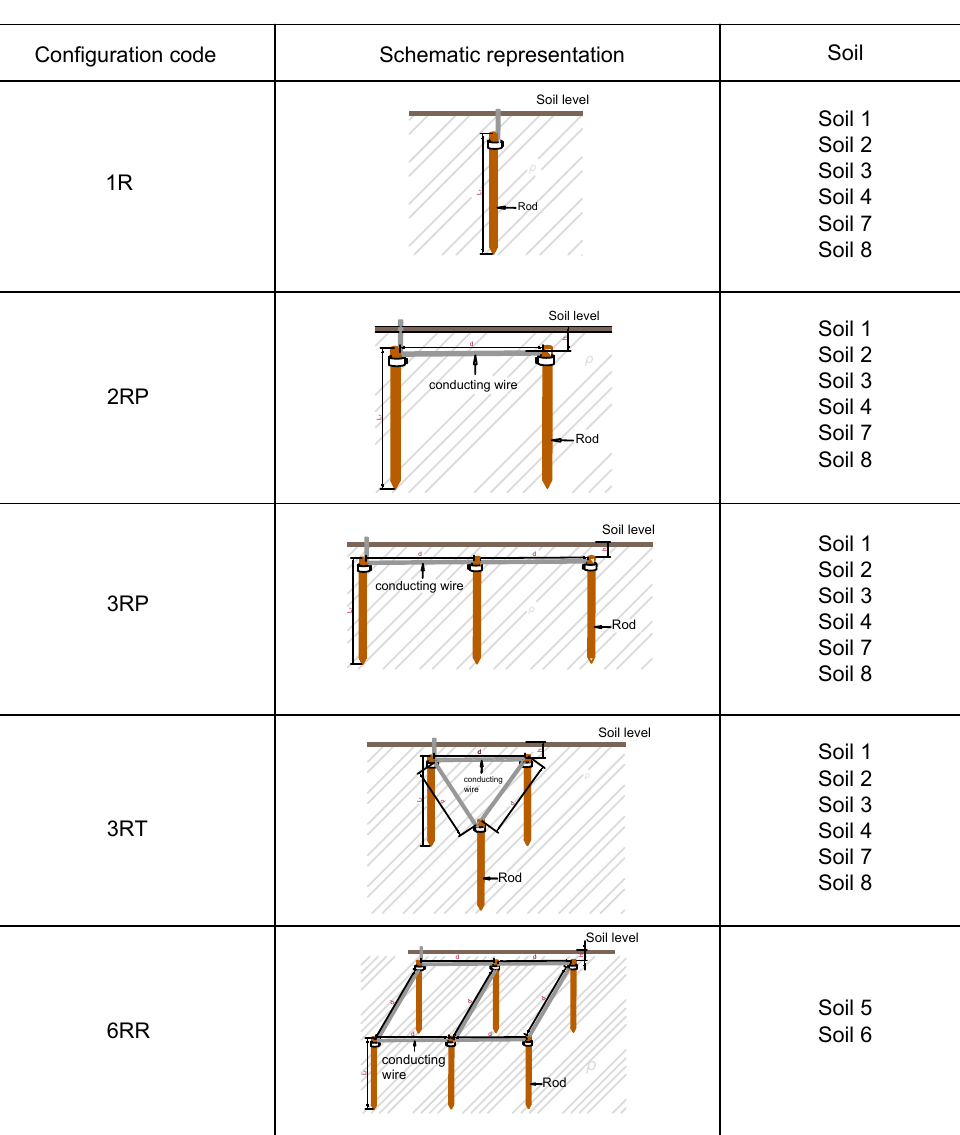
Figure 1. Basic GS configurations applied in each